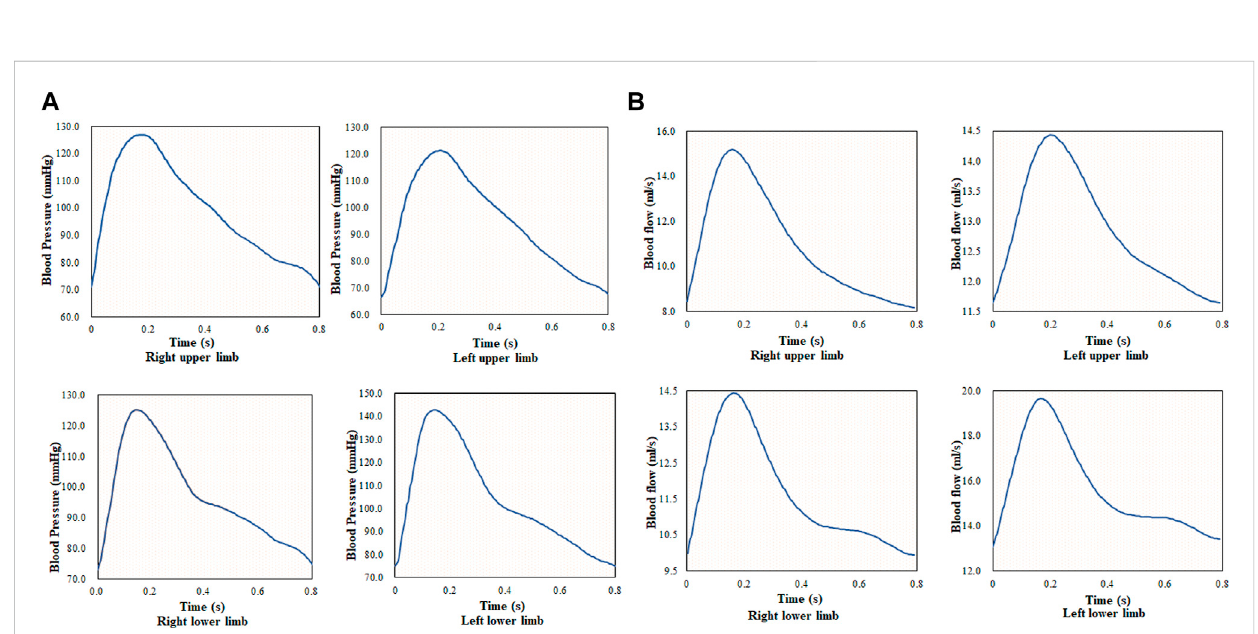
FIGURE 3 Pulsewaveformandblood fl owoffourlimbsduringonecardiaccycle; (A) pulsewaveformoffourlimbsduringonecardiaccycle,and (B) blood fl ow of four limbs during one cardiac